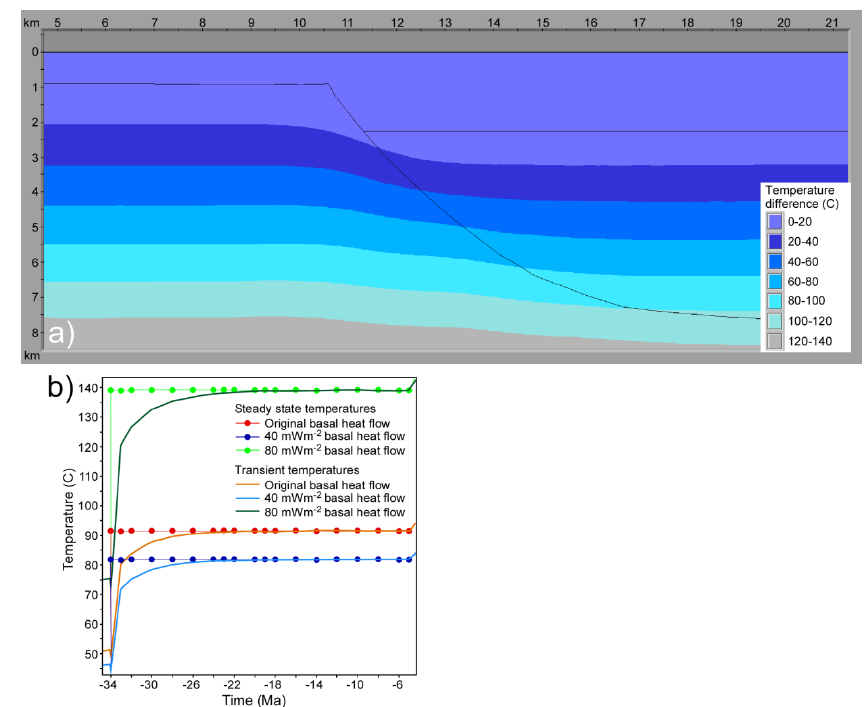
Figure 13. ( a ) Thermal difference between transient temperatures in basin with basal heat flow of 80 mW·m −2 , to basin with basal heat flow of 40 mW·m − 2 at 10 kyr after fault slip. ( b ) Results show the 80 mW · m − 2 , to basin with basal heat flow of 40 mW · m − 2 at 10 kyr after fault slip. ( b ) Results show the temperatures for the default and the two extreme values for heat flow: 47 mW·m −2 , 40 mW·m −2 , and temperatures for the default and the two extreme values for heat flow: 47 mW · m − 2 , 40 mW · m − 2 , and 80 mW·m −2 . Location of studied point is indicated in Figure 8b. 80 mW · m − 2 . Location of studied point is indicated in Figure